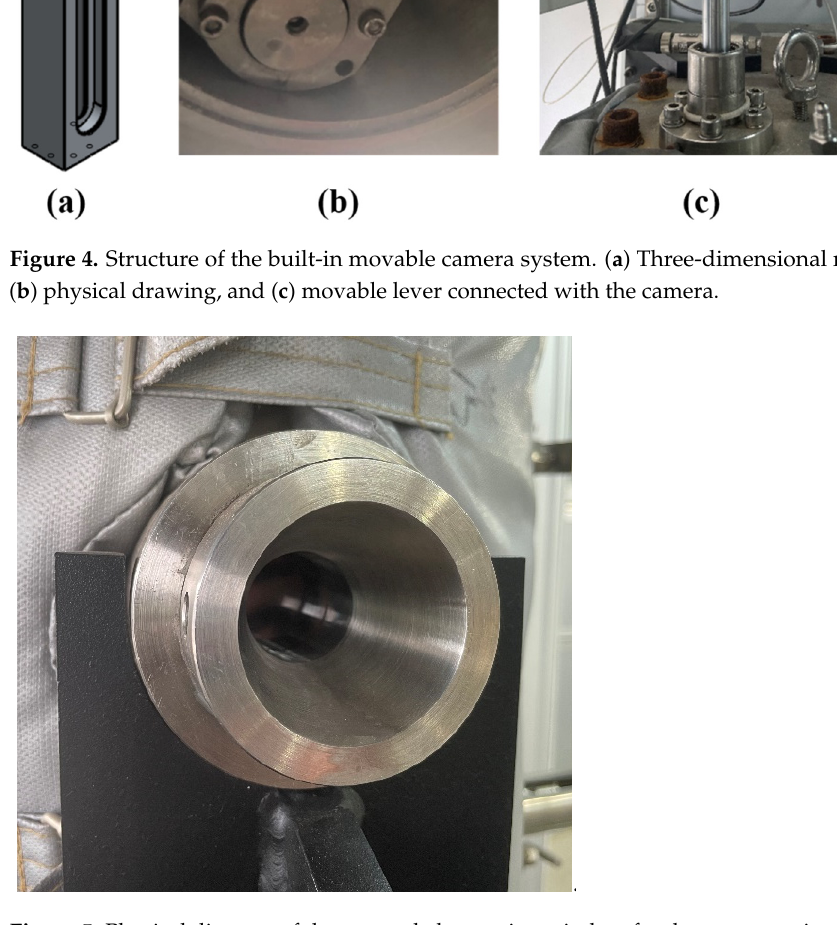
Figure 4. Structure of the built-in movable camera system. ( a ) Three-dimensional model drawing, ( b ) physical drawing, and ( c ) movable lever connected with the camera.